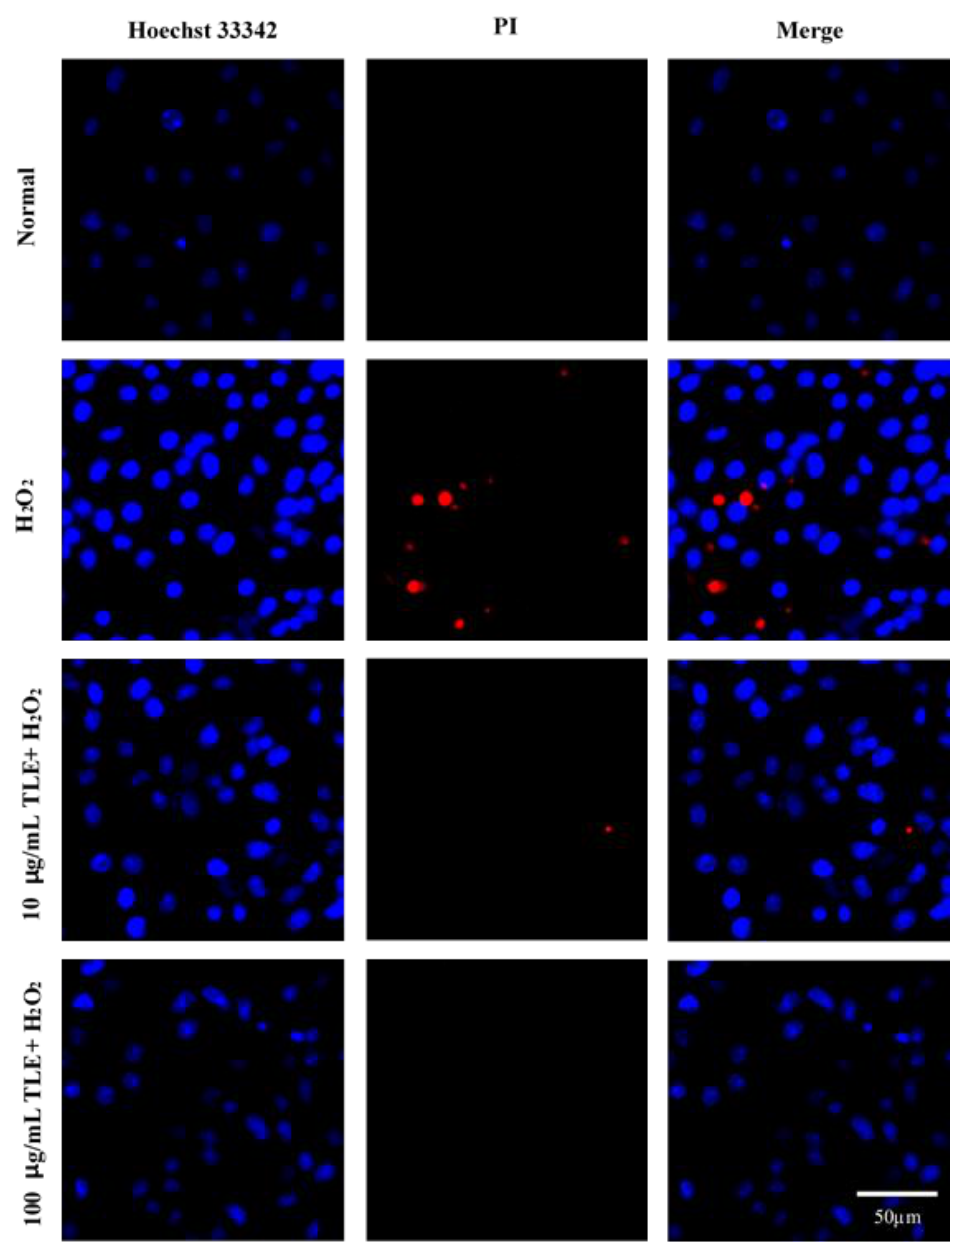
Figure 5. Fluorescence microscopy images of dual-stained Vero cells treated with TLE and 600 μM H 2 O 2 . H 2 O 2 was treated to Vero cells, which were pretreated with 10 μg/mL and 100 μg/mL TLE. Nuclei were stained with Hoechst 33342 (blue) and dead cells were stained with propidium iodide (PI) (red). Scale bar: 50 μm. TLE, turmeric leaves extract; PI, Propidium iodide.